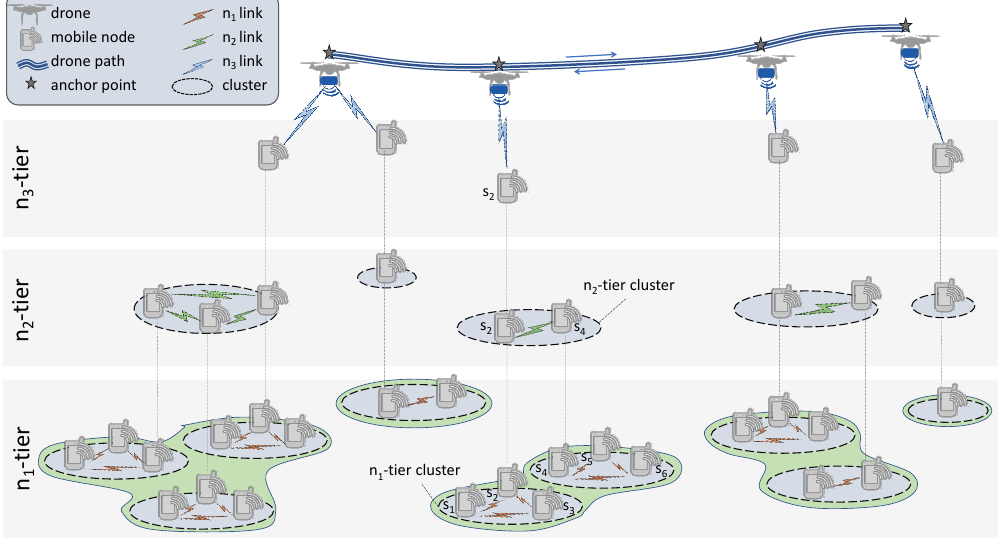
Figure 1. Multi-tier network architecture: (example of three communication